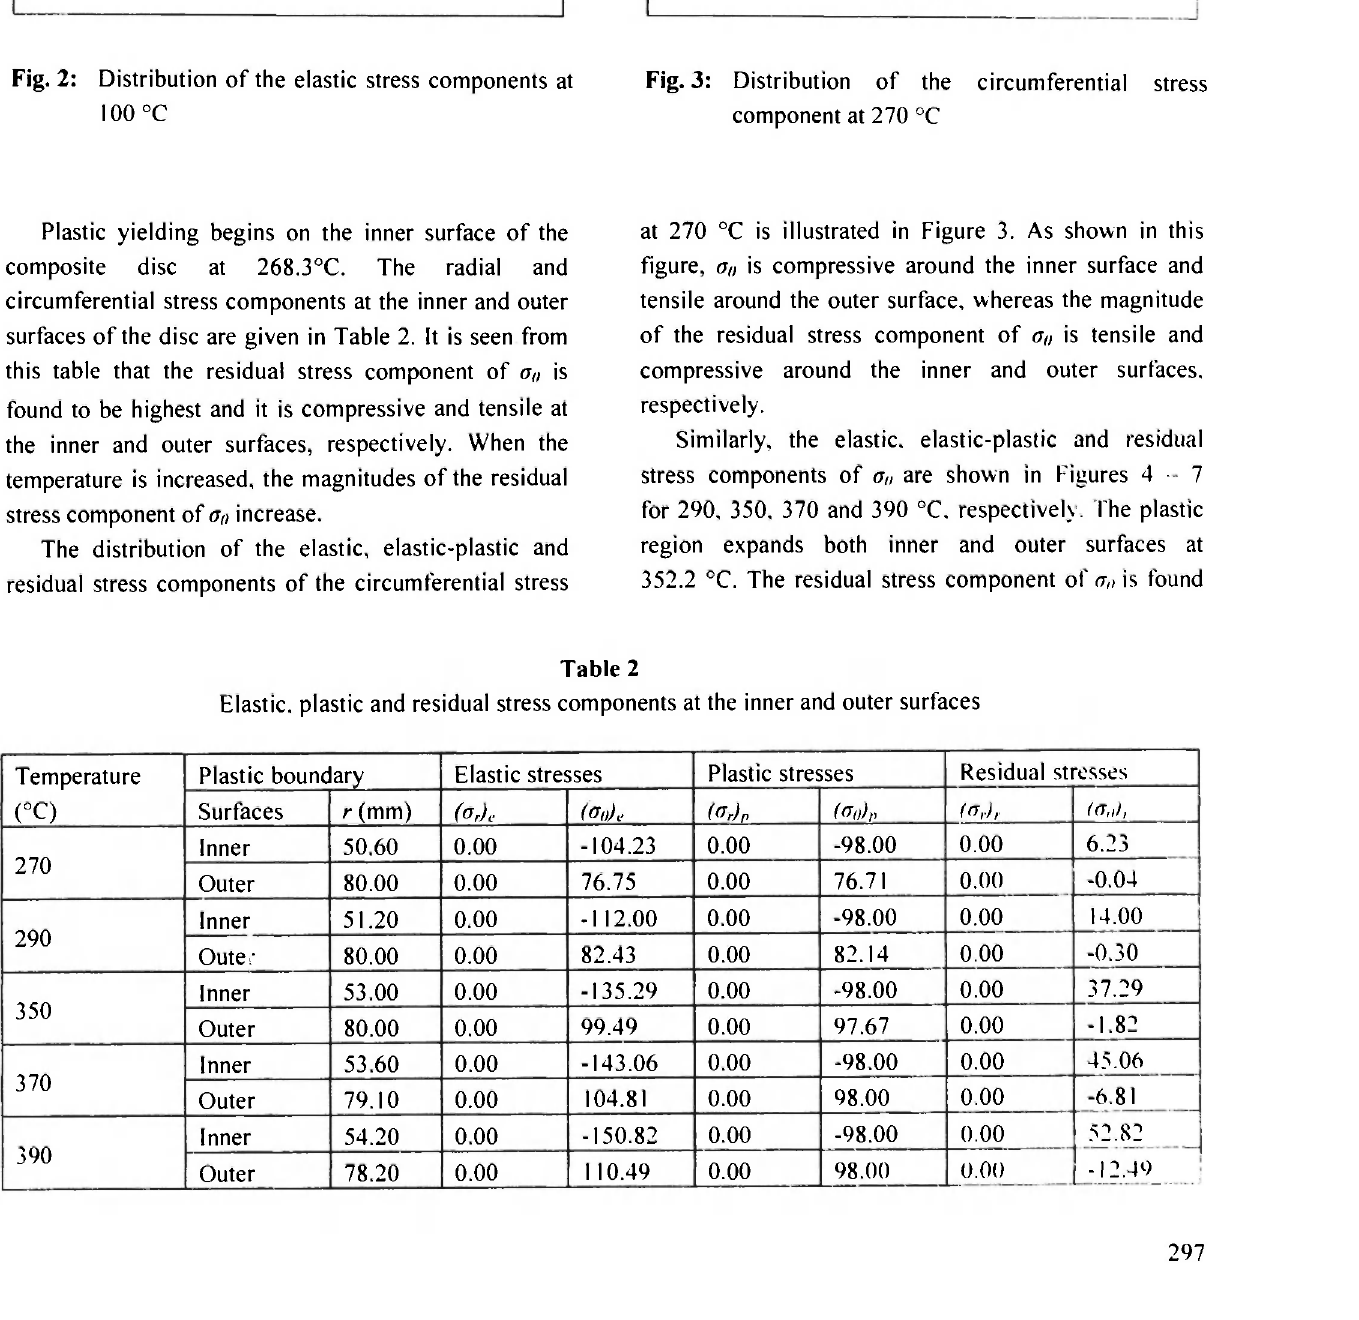
Fig. 2: Distribution of the elastic stress components at 100 °C